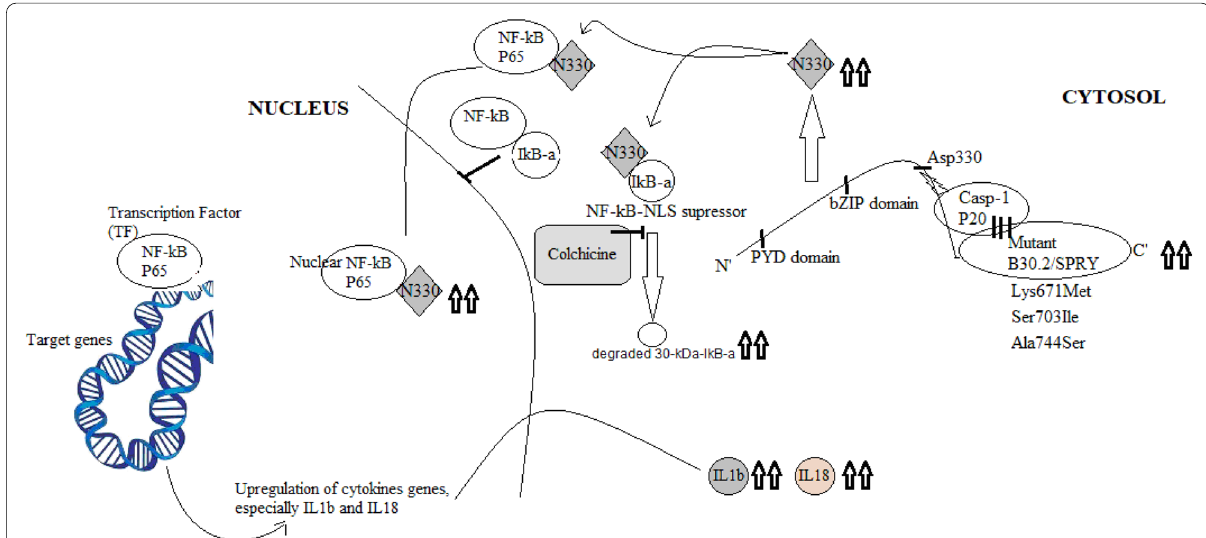
Fig. 5 Remodeling of ASC‑independent NF‑kB activation pathway (modified predictive model) according to our molecular mechanics scores of mutant B30.2/SPRY domain. The three upright lines between casp‑1/p20 and B30.2/SPRY mean high binding affinity, while the upright arrows mean elevated quantity, and the bold truncated line means inhibitory